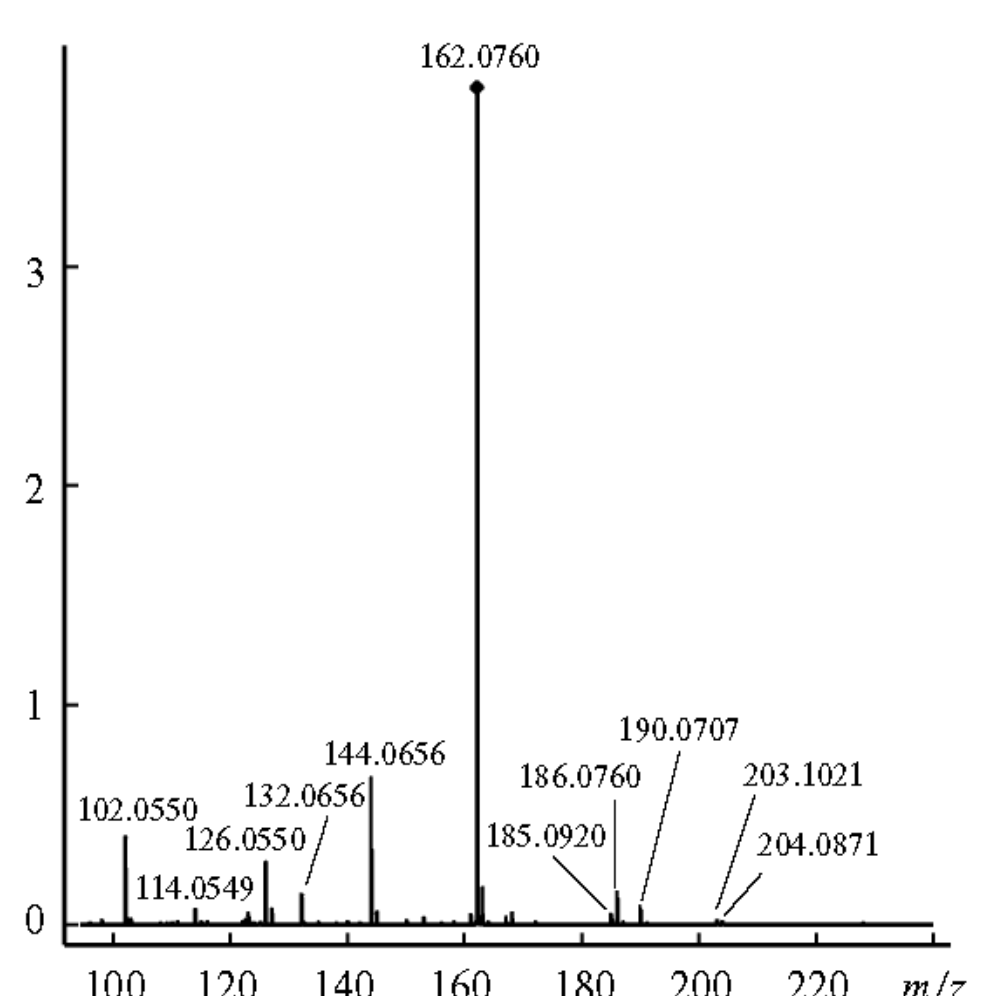
Figure 19. CID MS 2 (10 eV) of the [M + 2H] 2+ ion of compound 19a (reproduced from [70]